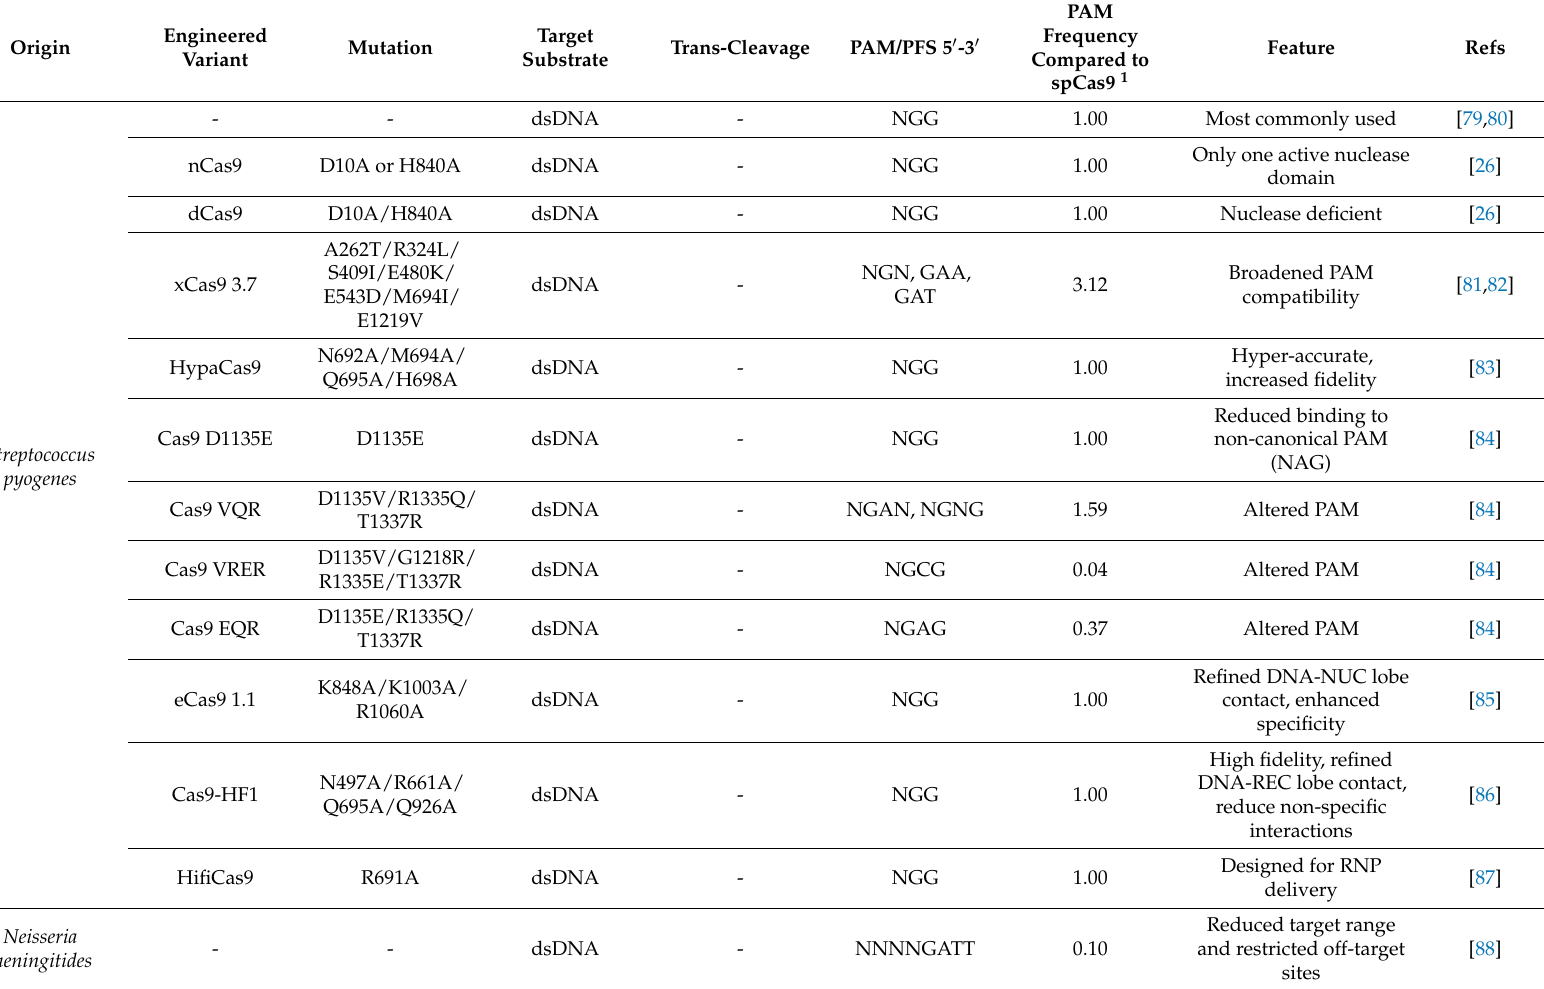
Table 1. Single subunit Cas endonucleases and their fun